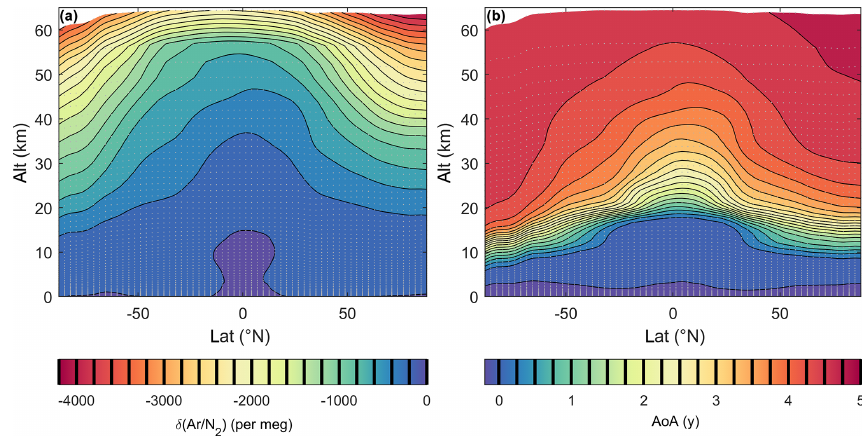
Figure 6. Annual and zonal means of δ( Ar / N 2 ) (a) and age of air (AoA) (b) simulated by TOMCAT. Values of the contour lines are shown as black vertical lines on the color bar. Grey dots indicate the center of a grid box in TOMCAT. A video of this figure highlighting the natural variability in monthly-mean values is available in the Supplement.